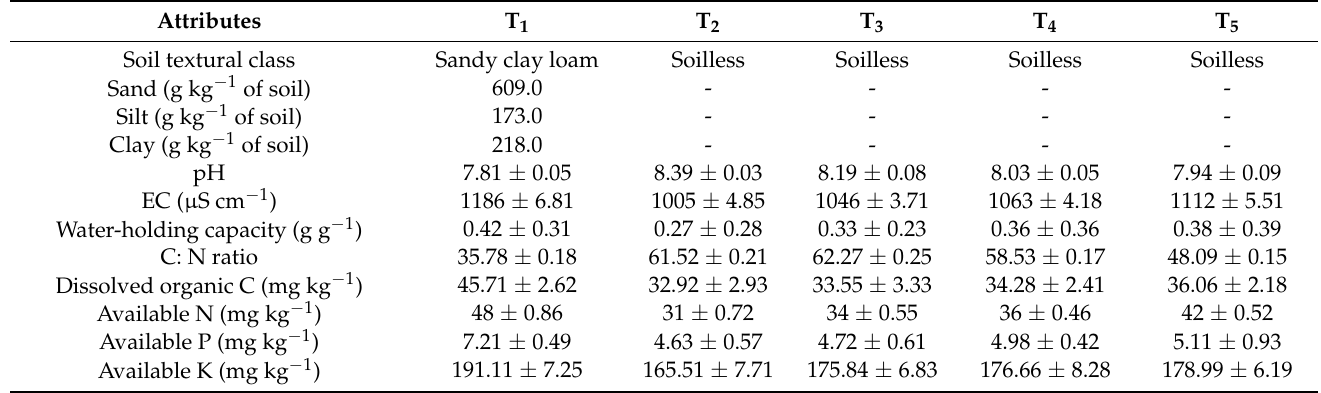
Table 1 lists the physiochemical characteristics of the non-fertilized B. ceiba sawdust combinations and unfertilized soil samples that were used in the experiments. Table 1. Experiments utilized the fundamental physiochemical features of the soil and non-composted B. ceiba sawdust combinations. T 1 : non-fertilized 100% sandy clay loam soil (control) ( v / v ), T 2 : non-